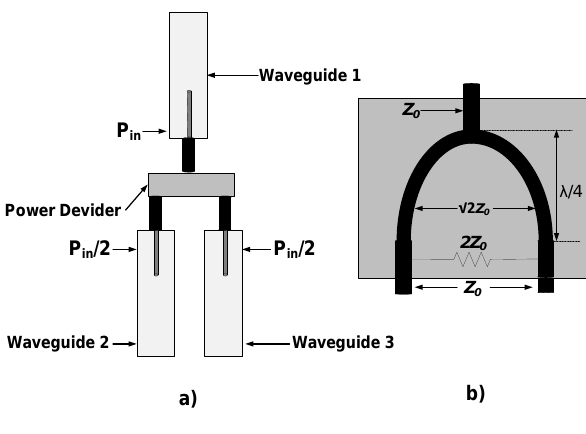
Fig10. a) Power further divides to different waveguides; b)